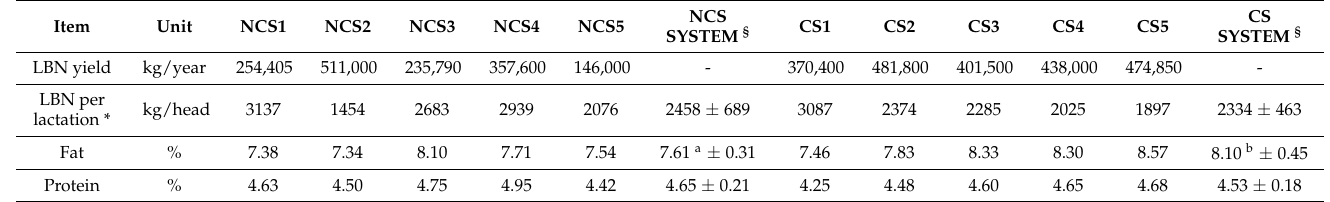
Table 2. Milk production traits of non-corn silage (NCS) and corn silage (CS)